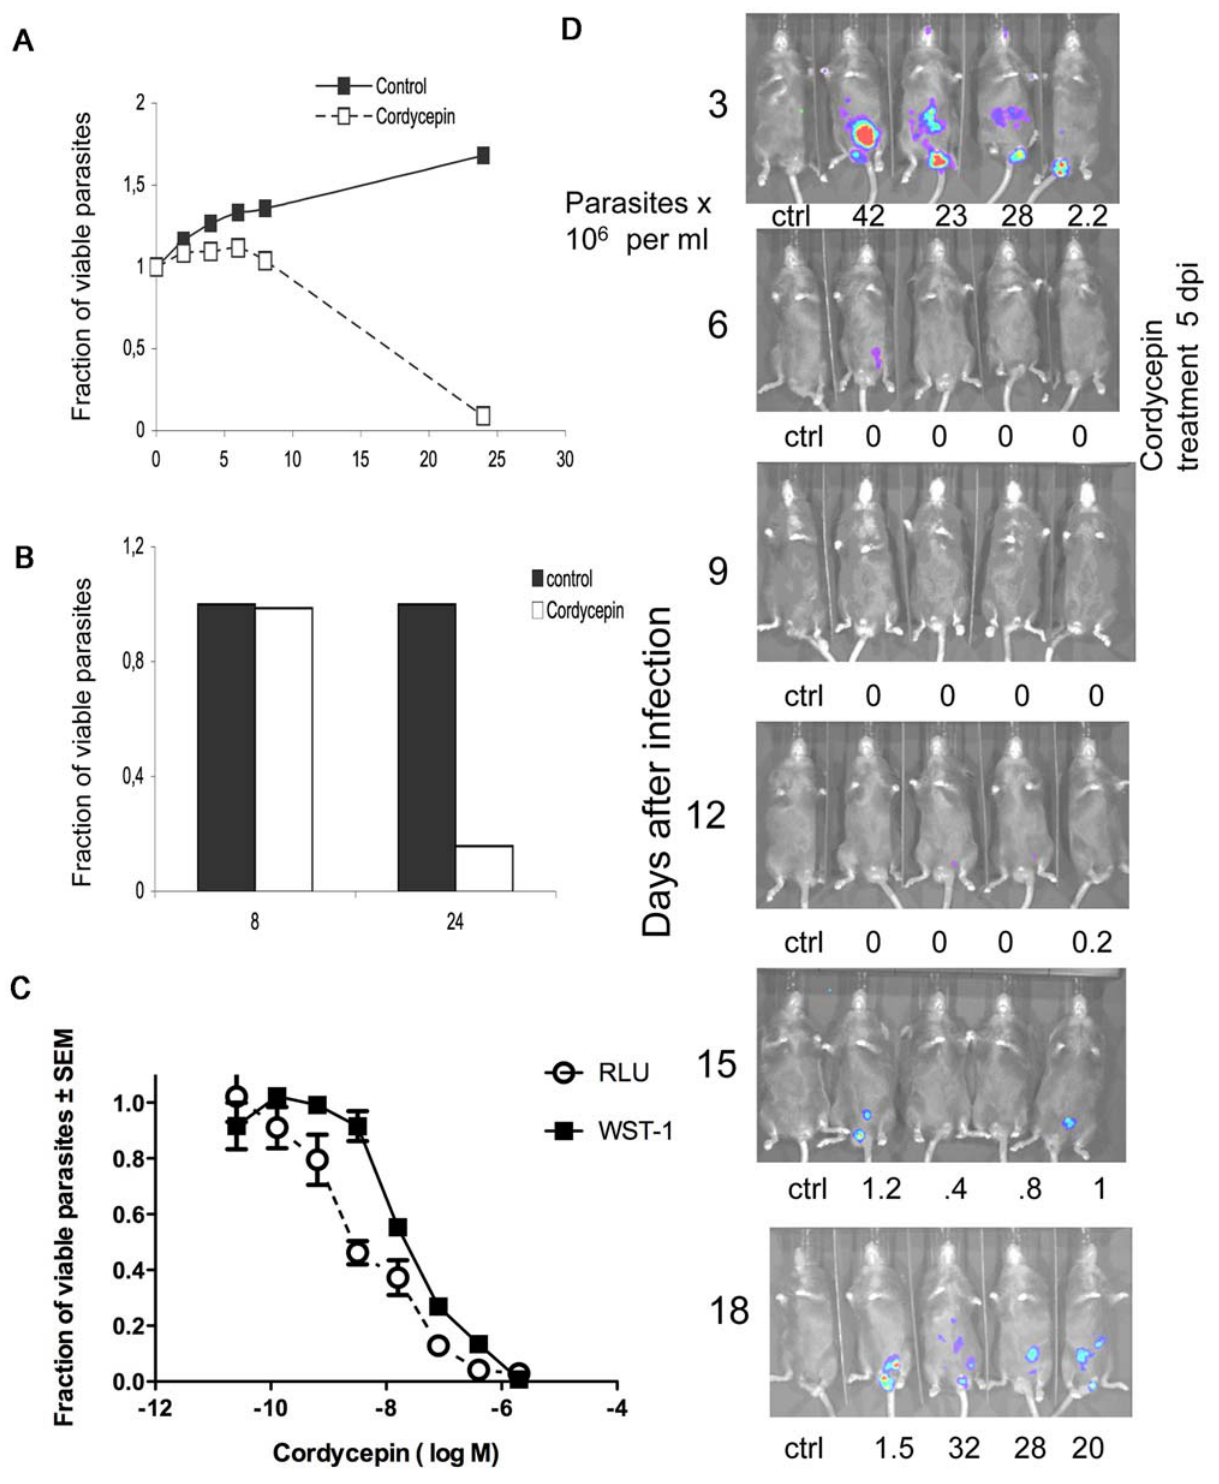
Figure 5. A sub-curative treatment with cordycepin and deoxycoformycin shows light emission in the testis. A, B. Parasites (10 6 per ml) were incubated with 2 m M cordycepin or medium. The light production (A) or the viability as determined by a WST-1 assay (B) measured in triplicate cultures at different time points (in hours) after incubation. Results are expressed as fraction of the controls determined at 0 h of incubation. C. T.b. brucei Lister 427 (2 6 10 4 cells) were incubated with different concentrations of cordycepin. The RLU and the parasite viability were determined 72 h after incubation. Results are expressed as fraction of each parameter in relation to the untreated controls. D. Kinetics of infection of RAG1 2 / 2 male mice with recombinant T.b. brucei Lister 427. RAG1 2 / 2 mice were infected ip with 100 T.b. brucei Lister 427. Five days after infection mice were treated i.p. with 2 mg/kg cordycepin daily for 3 days. Parasite load was measured by bioluminescence imaging and parasitemia was registered.